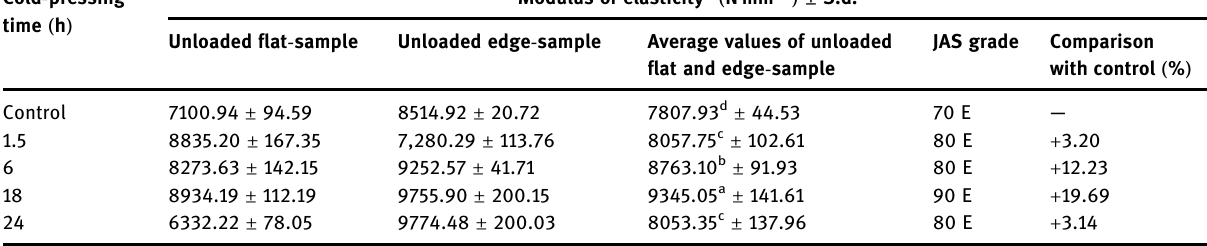
Table 7: Average value of modulus of elasticity of unloaded LVL Cold - pressing time ( h